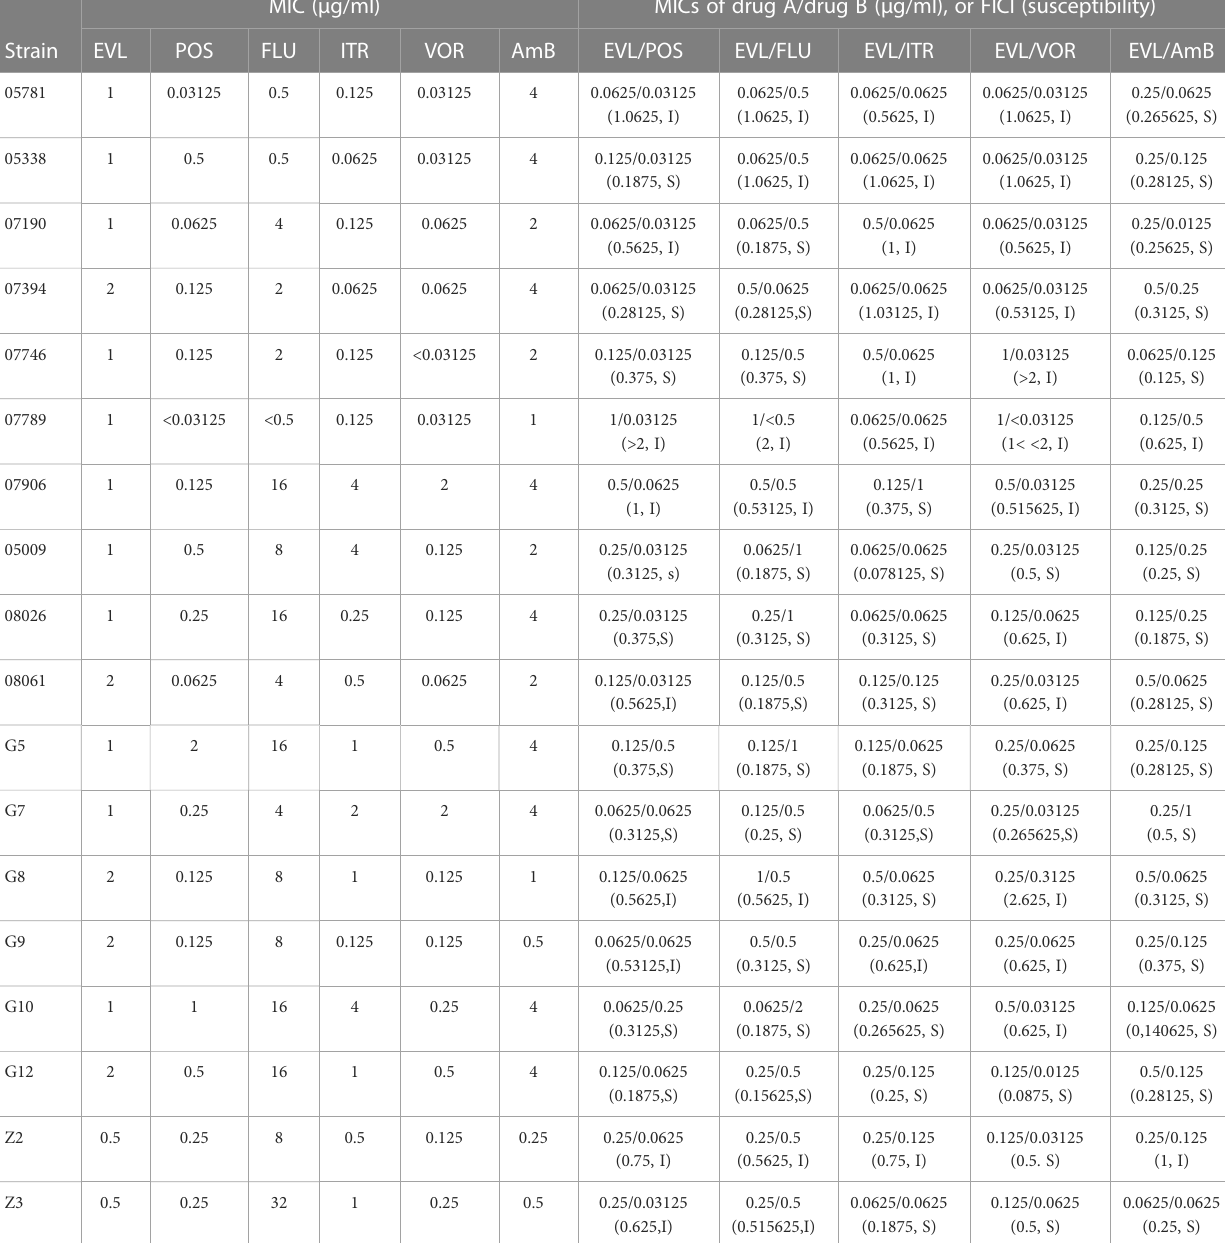
TABLE 1 MICs and FICIs results with combinations of Everolimus with antifungal agents against Cryptococcus neoformans .